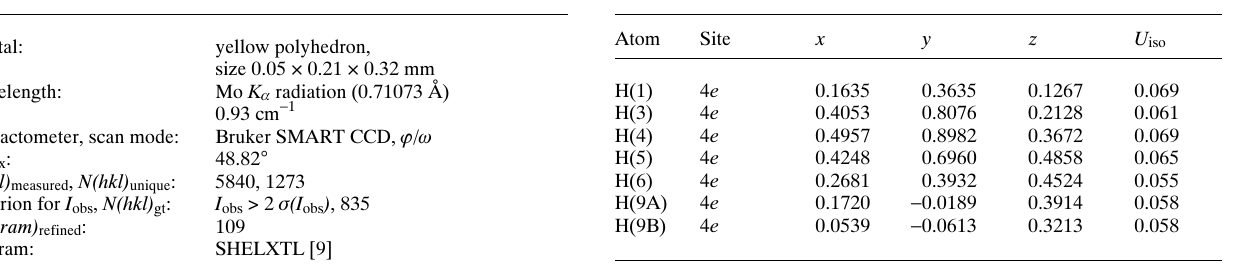
Table 2. Atomic coordinates and displacement parameters (in Å 2 ) . Table 1. Data collection and handling.